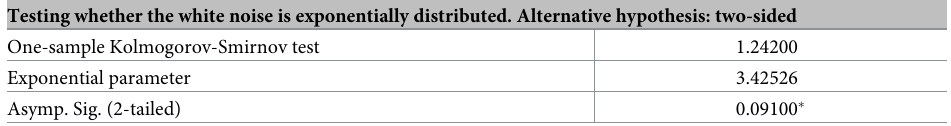
Table 7. Testing the suitability of an exponential distribution for the exponential white noise. Testing whether the white noise is exponentially distributed. Alternative hypothesis: two-sided One-sample Kolmogorov-Smirnov test Exponential